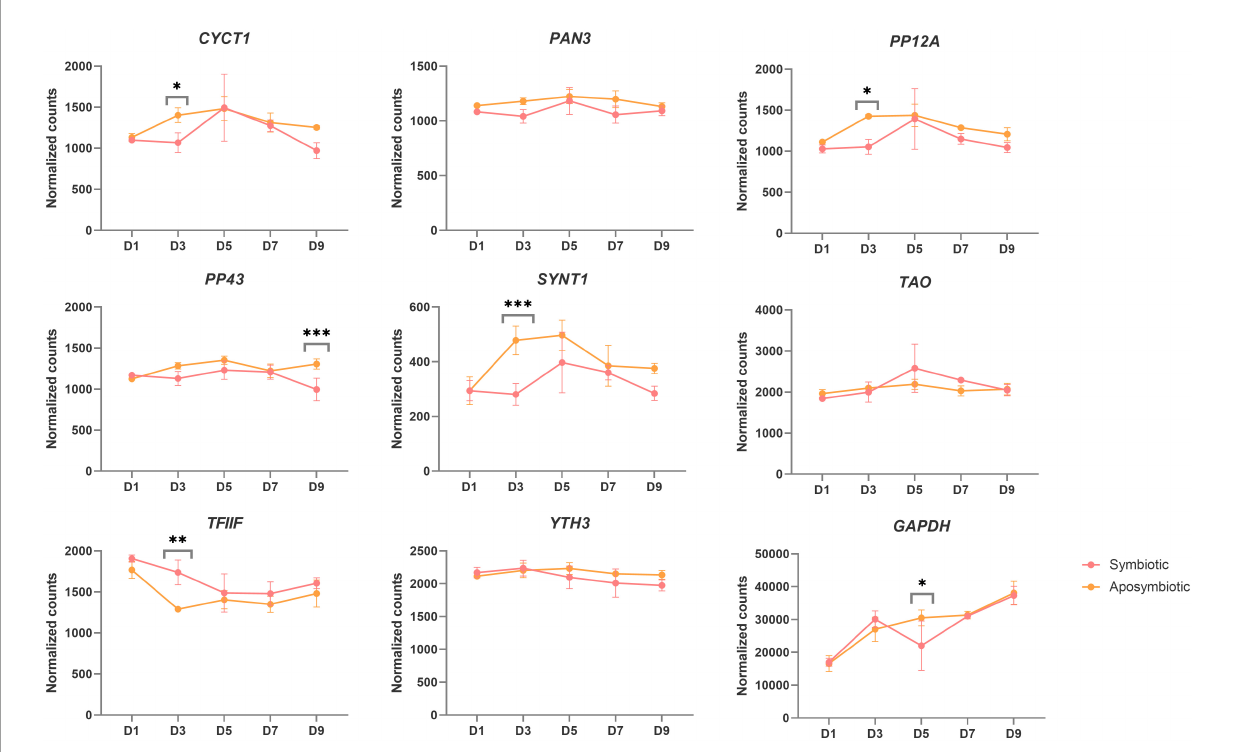
FIGURE5 Normalized counts of selected candidate reference genes from previous RNAseq data obtained from symbiotic and aposymbiotic weevils (Ferrarini et al., 2023). Stars denote the adjusted p -value between symbiotic and aposymbiotic weevils at a given time point, upon DESEQ2 analysis (see section “2. Materials and methods”). ∗ Adjpvalue < 0.05, ∗∗ < 0.005, ∗∗∗ < 0.0005. Three genes show no differences between symbiotic and aposymbiotic weevils at any given time point and constitute good candidates for symbiotic/aposymbiotic qRT-PCR comparisons: pan3 , tao , and yth3